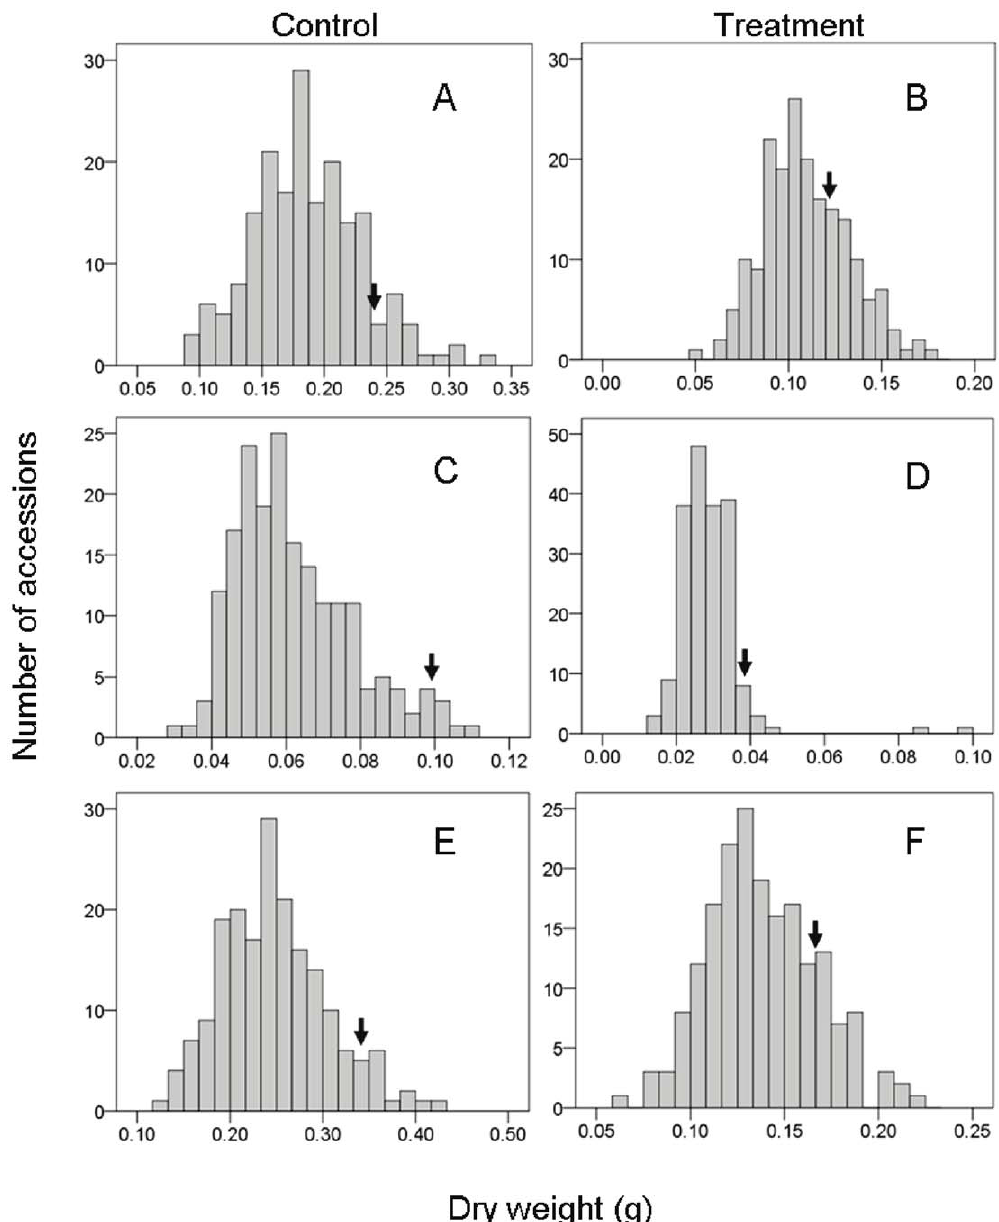
Figure 1. The frequency of dry weight of Tibetan barley. Graphs show the frequency of dry weight (shoot, root or whole-plant) of 188 accessions under control (0 mM NaCl) (A, C and E) or treated (300 mM NaCl) conditions (B, D and F). Arrows indicate the control cultivar, CM72.